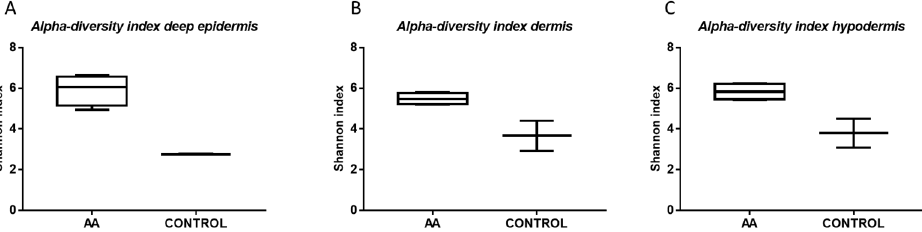
Figure 2. Alpha diversity index. All the diversity indices for ( A ) deep epidermis, ( B ) dermis, and ( C ) hypodermis in AA and healthy control group are expressed as Shannon index.